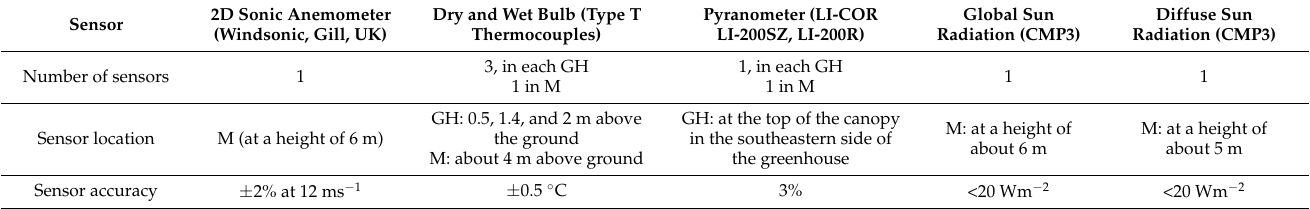
Table 1. System of sensors in the greenhouses (GH) and in the meteorological station